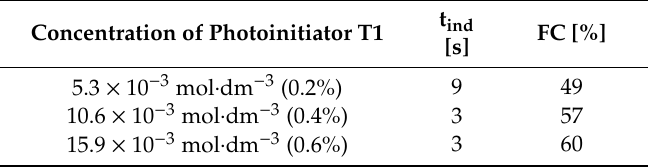
Table 4. Functional group conversions of acrylate monomer TMPTA using di ff erent concentration of a photoinitiator T1 under LED 405 nm.